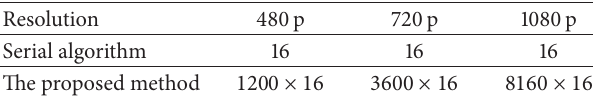
Table 3: Available parallelism of different DB